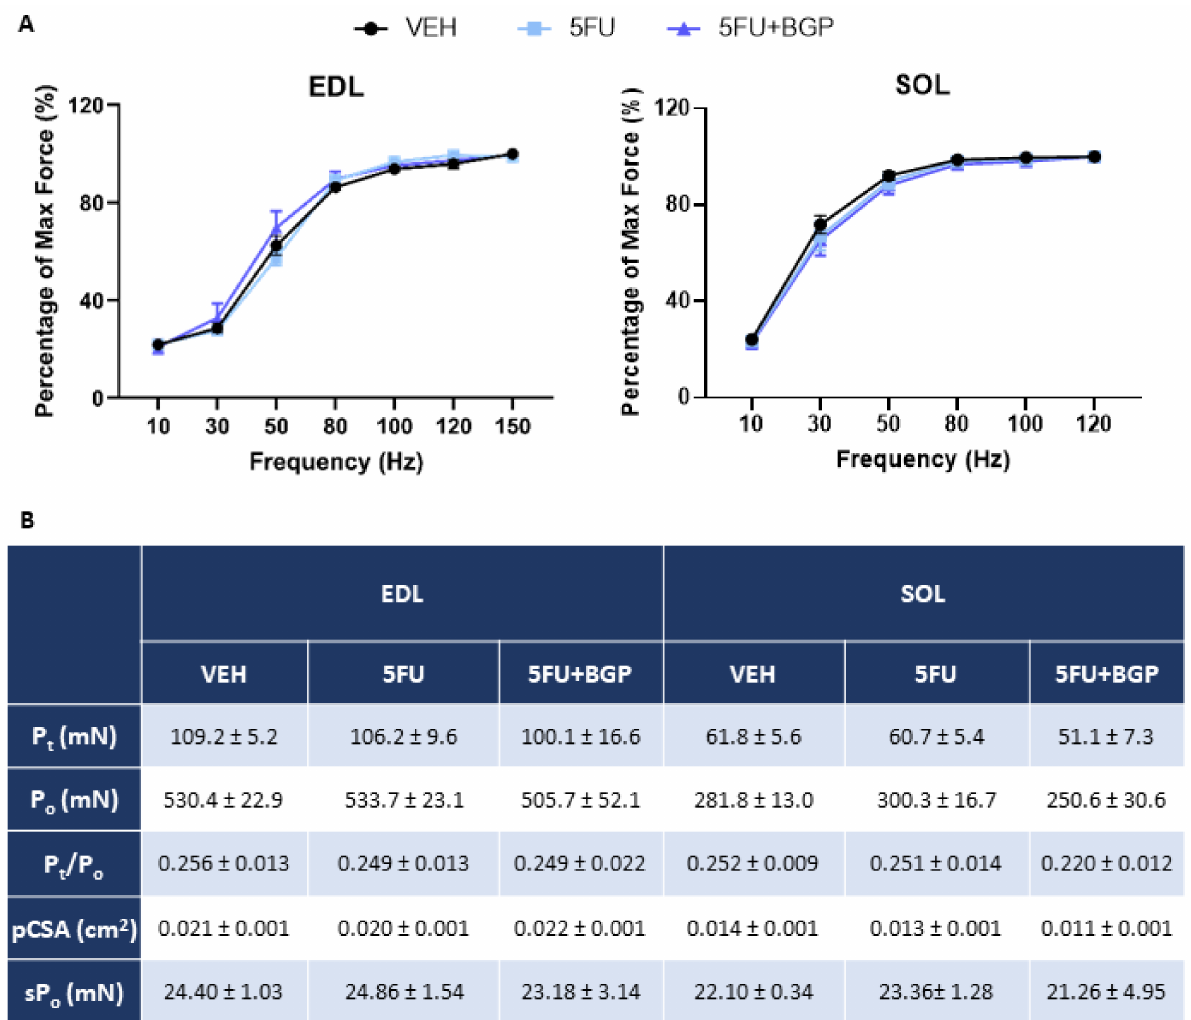
Figure 2. The effect of 5-fluorouracil (5FU) and 5FU with BGP-15 (5FU+BGP) treatment on skeletal muscle contractile function. Extensor digitorum longus (EDL) and soleus (SOL) muscles underwent ex vivo assessment of contractile functional properties, with ( A ) force–frequency relationships and ( B ) force production characteristics analyzed, including; Peak twitch force (P t ), Absolute tetanic force production (P o ), twitch to tetanus ratio (P t /P o ), physiological cross-sectional area (pCSA) and Specific force production (sP o ). n = 4–8 for ex vivo contractile function. Data are mean ±